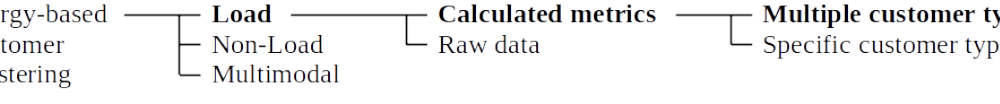
Figure 1. Taxonomy of energy customers clustering